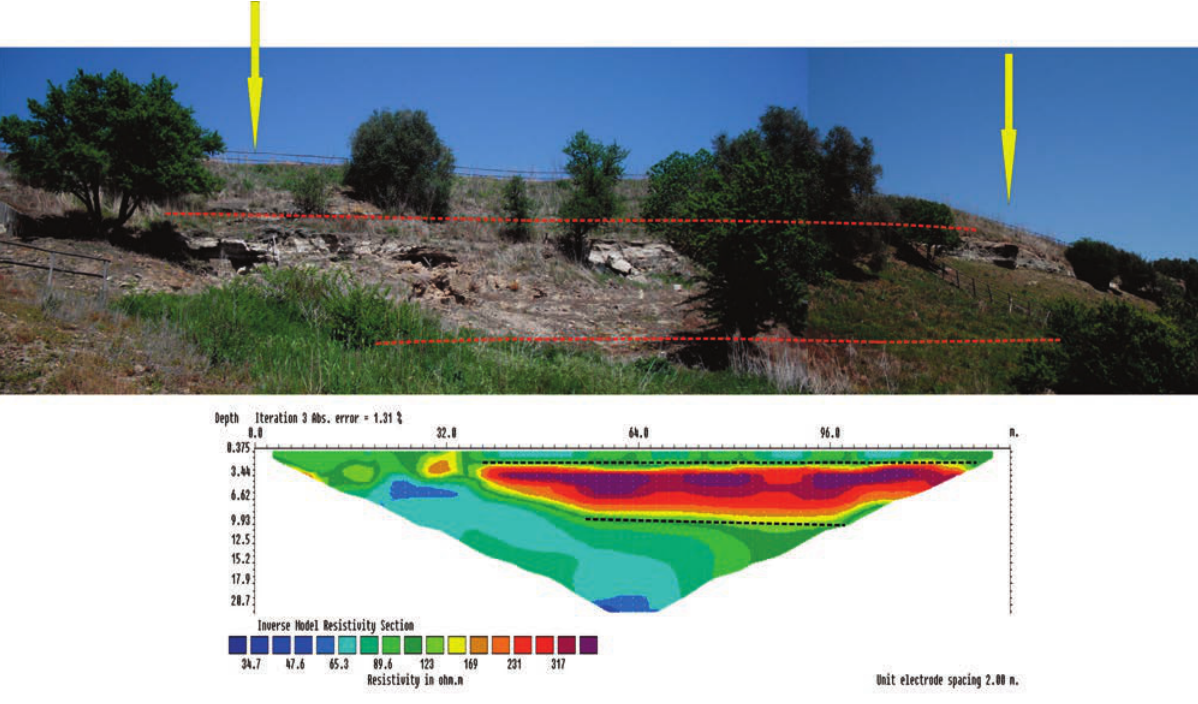
Figure 10. Eletric Resistivity Tomography performed on a